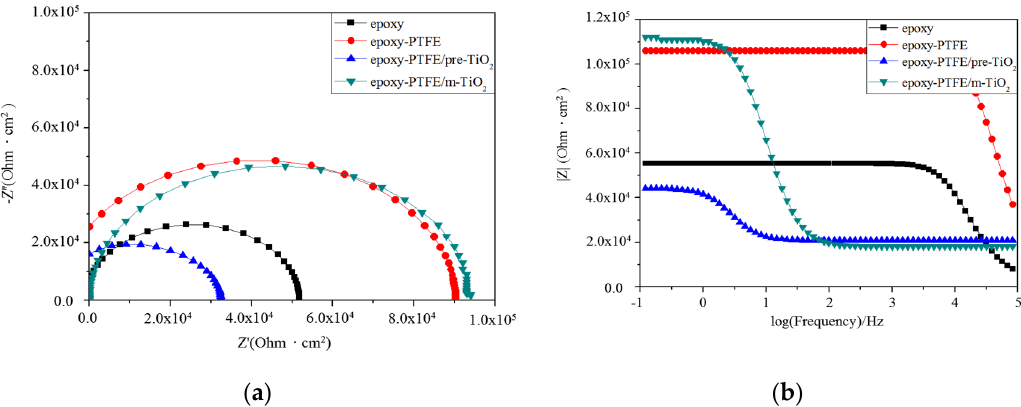
Figure 10. Electrochemical impedance of the coatings. ( a ) Nyquist, ( b ) Bode.